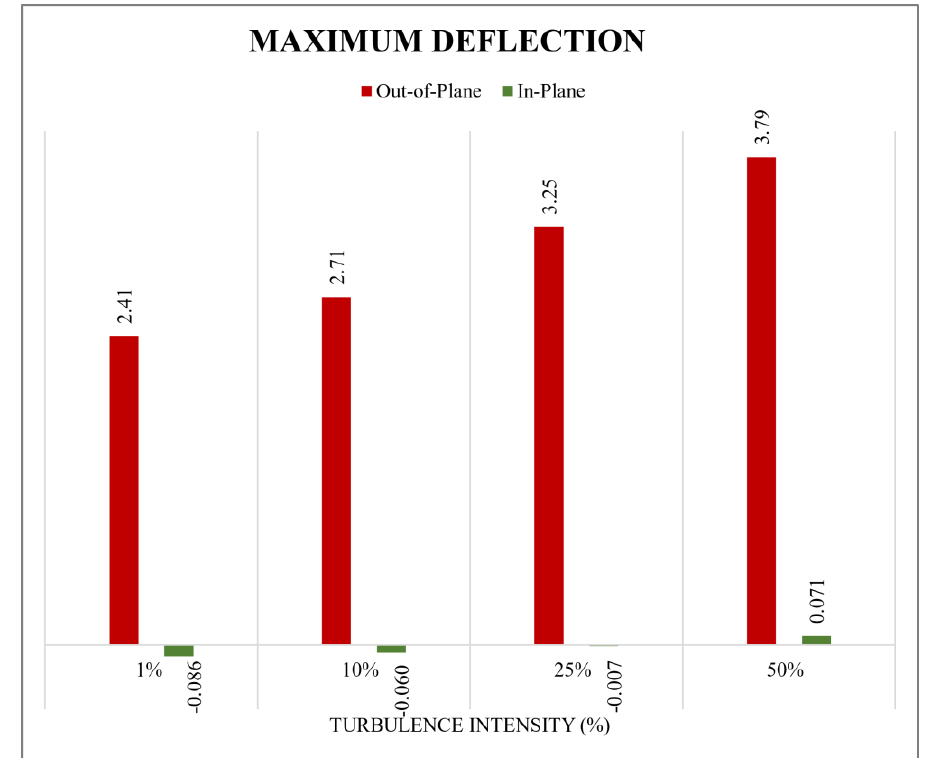
Figure 17. Maximum Value of the Blade